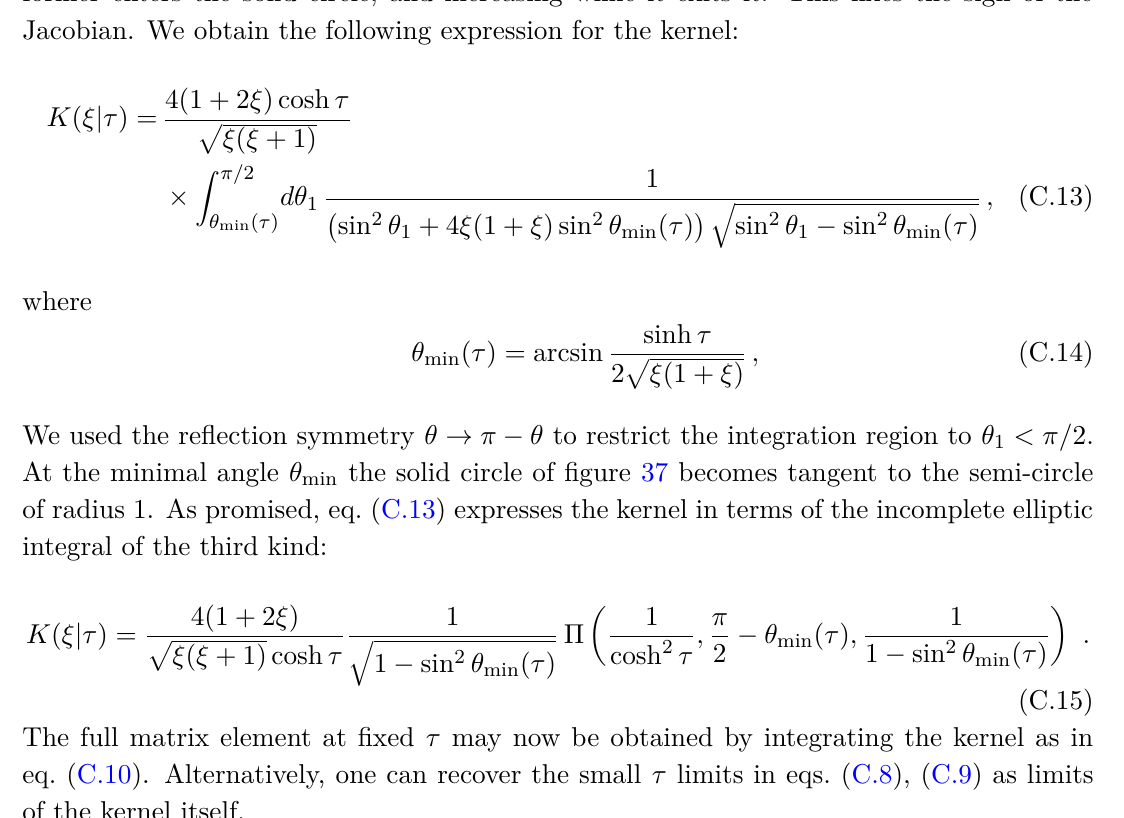
. The V insertion at angle θ is generic. 1 2